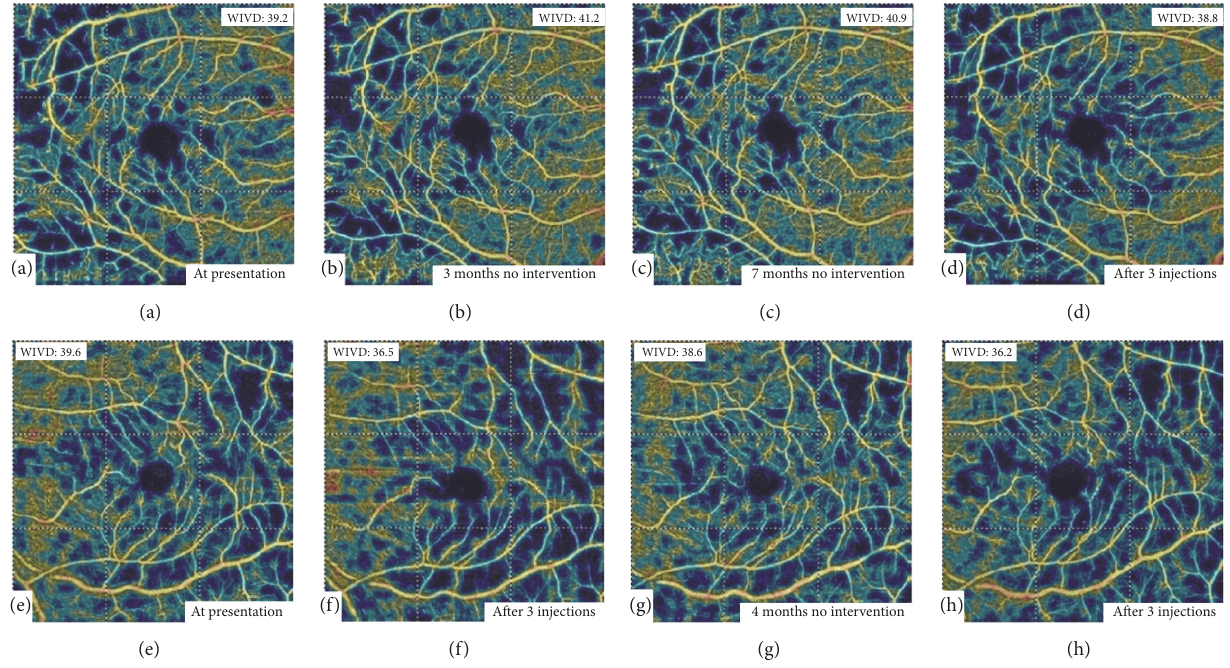
Figure 3: OCTA of the SCP of the right (top row) and left (bottom row) maculae. At presentation, there were areas of capillary nonperfusion detected in the SCP of both eyes especially temporally (a and e). Following three months of no intervention in the right eye and three monthly intravitreal injections in the left eye, there was increased vascular density (VD) in the right eye (b) and decreased VD in the left (f). After four months of no interventions in either eye, there was no change in the VD in the right eye (c) and increased VD in the left (g). Finally, following three monthly intravitreal injections in both eyes, there was decreased VD in both eyes (d and h). Scan quality was 6/10 or higher in all images and there were no significant segmentation errors detected. Whole image vascular density (WIVD), as measured by the built-in machine software, is shown at each